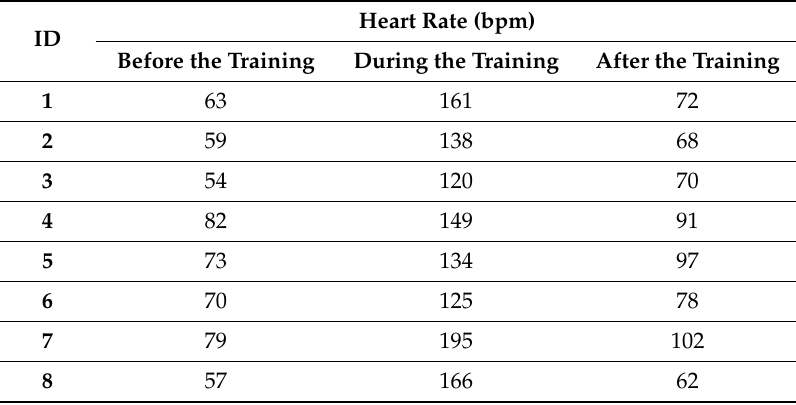
Table 4. Heart rate of all the eight athletes measured before, during and after the training. Heart Rate (bpm) ID Before the Training During the Training After the